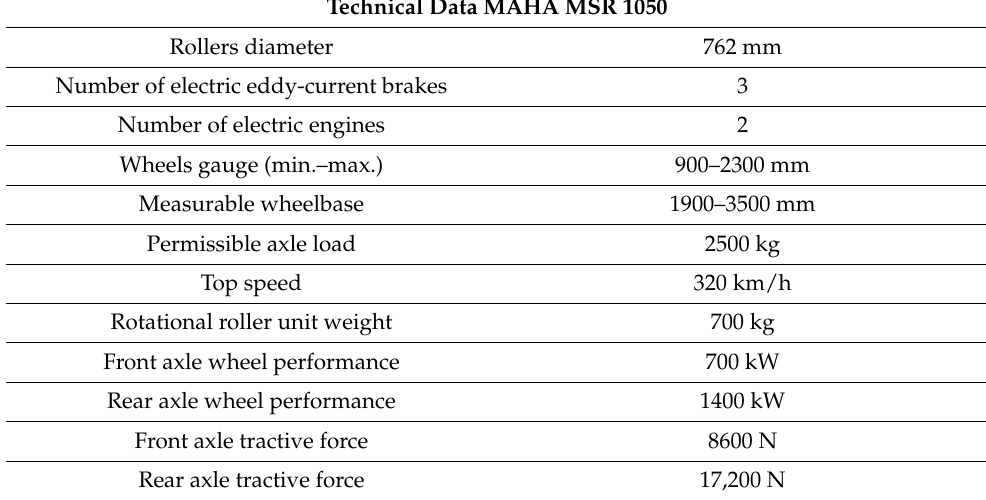
Table 2. Technical data MAHA MSR 1050 [32].